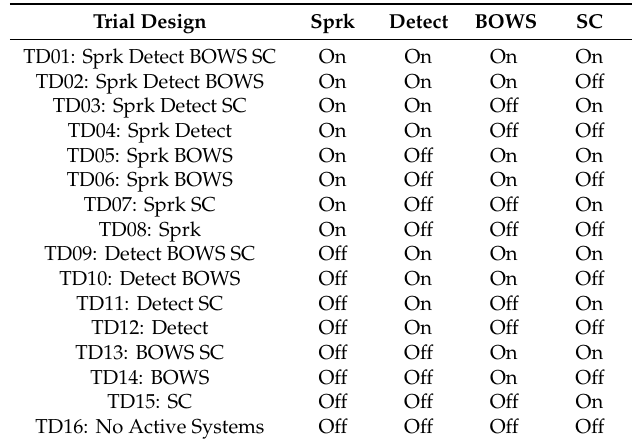
Table 4. Fire safety systems considered for case studies.